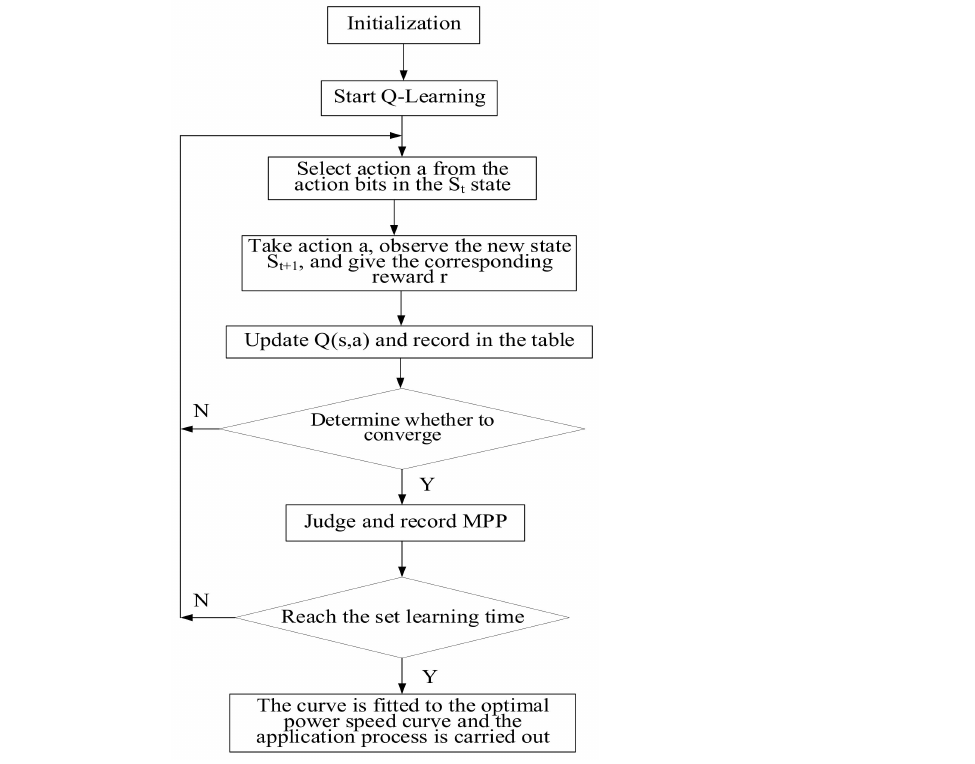
Figure 3. Flow chart of MPPT intelligent control algorithm based on